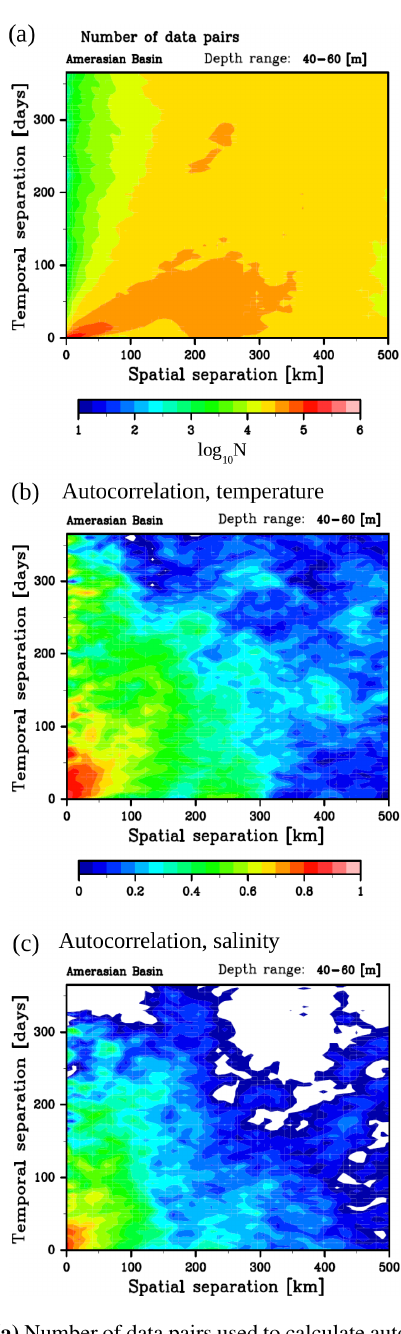
Figure 9. (a) Number of data pairs used to calculate autocorrelation in each bin (log-scale) and two-dimensional autocorrelation func- tion for (b) temperature and (c) salinity in 40–60m depth range. The color bar for panel (b) is common to (c) . The white area in panels (b) and (c) indicates negative autocorrelations.